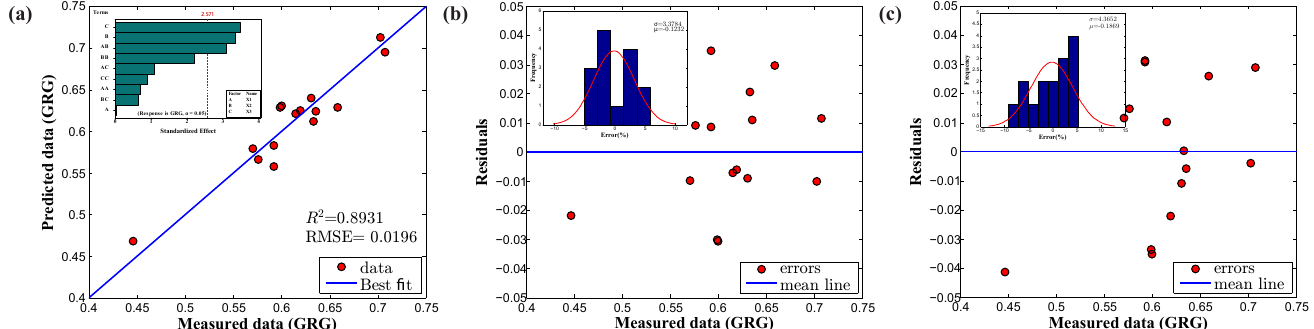
Figure 10. Full model ( a ) correlation plot; ( b ) residual plot; ( c ) residual plot of reduced